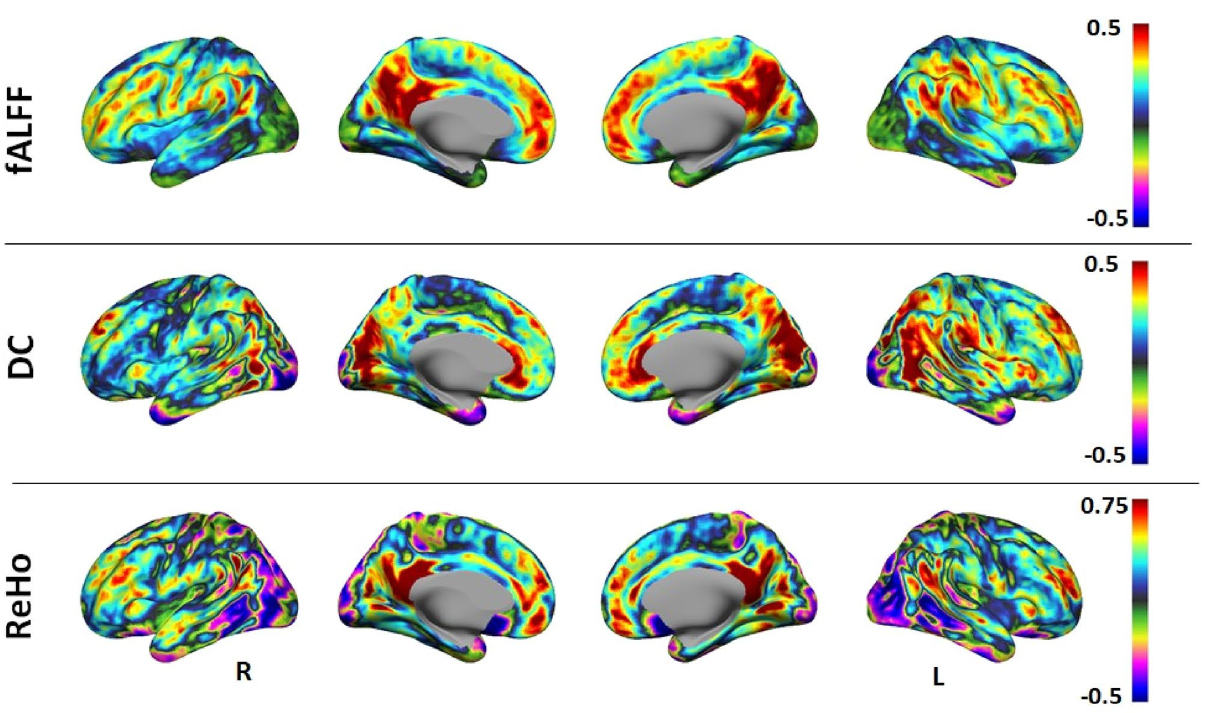
Figure 3. RS-fMRI measures. The fMRI measures fALFF (top row), DC (middle row) and ReHo (bottom row) are shown in right, right medial, left medial and left views. The figure was created using MATLAB (The MathWorks, Inc., Natick, United States, Version 9.5 (R2018b)) based software package CONN (version v.18.b; https:// www. nitrc. org/ frs/? group_ id=